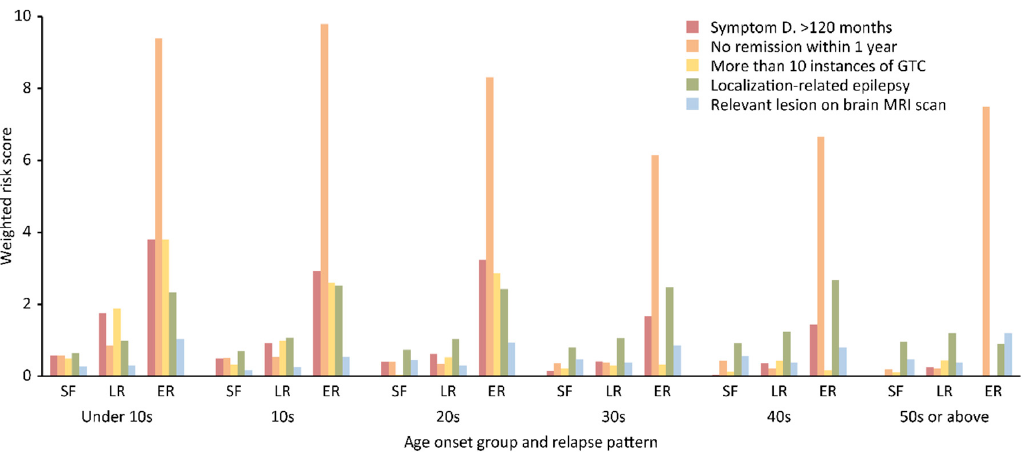
within 1 year in ER patients was the most important factor in every age group, and localization-related